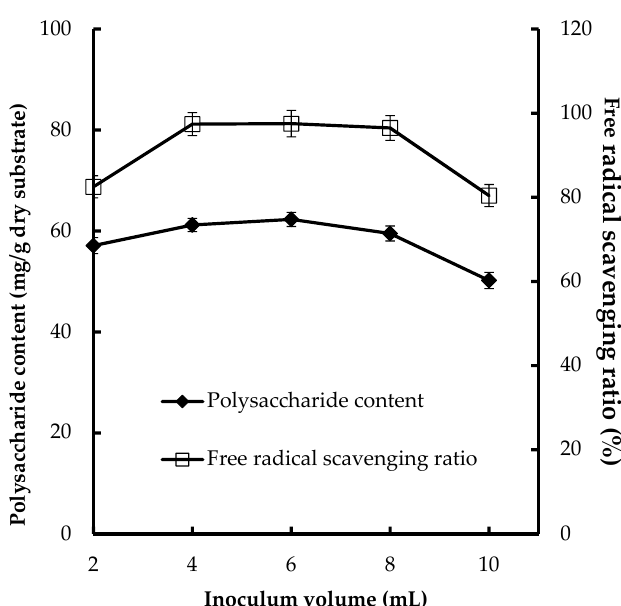
Figure 1. Effect of inoculum volume on CPS production and antioxidant activities of substrate.